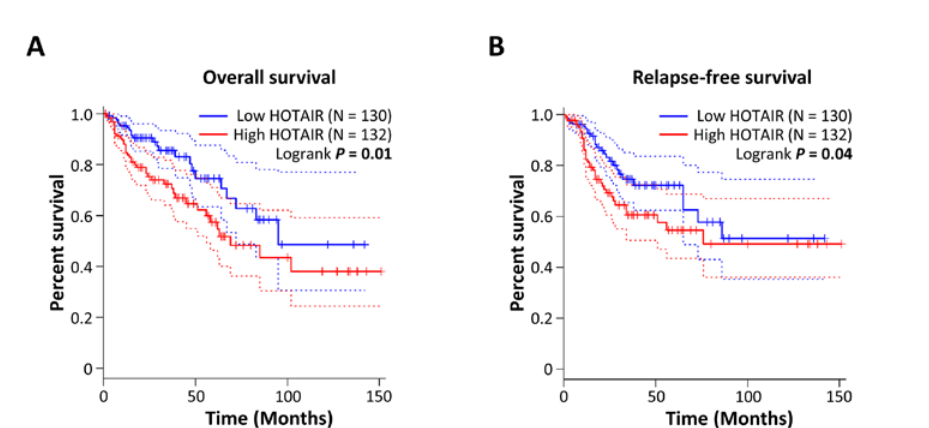
Figure 3: Sensitivity analysis for overall survival in colorectal cancer.